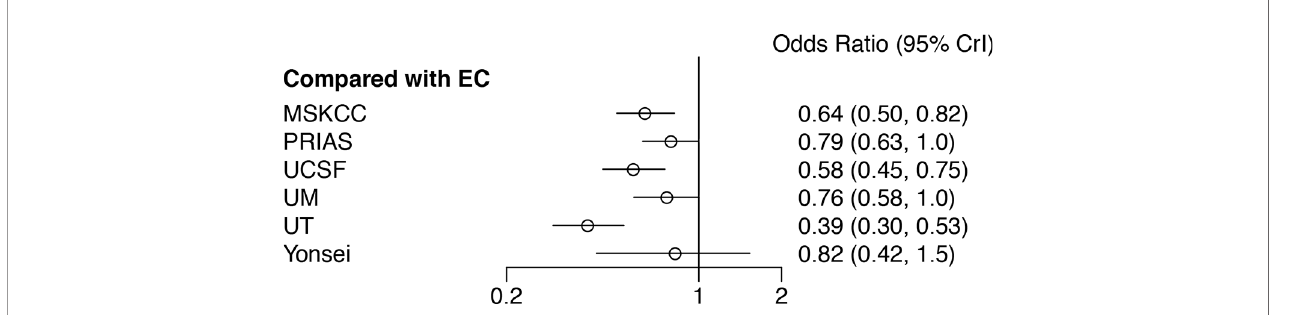
FIGURE 2 | Forest plot showing a comparison of the diagnostic performance of all other included AS criteria in comparison to that of the EC. An OR greater than one represents a bene fi t relative to EC in terms of diagnostic accuracy for insigni fi cant prostate cancer. EC, Epstein Criteria; PRIAS, Prostate Cancer Research